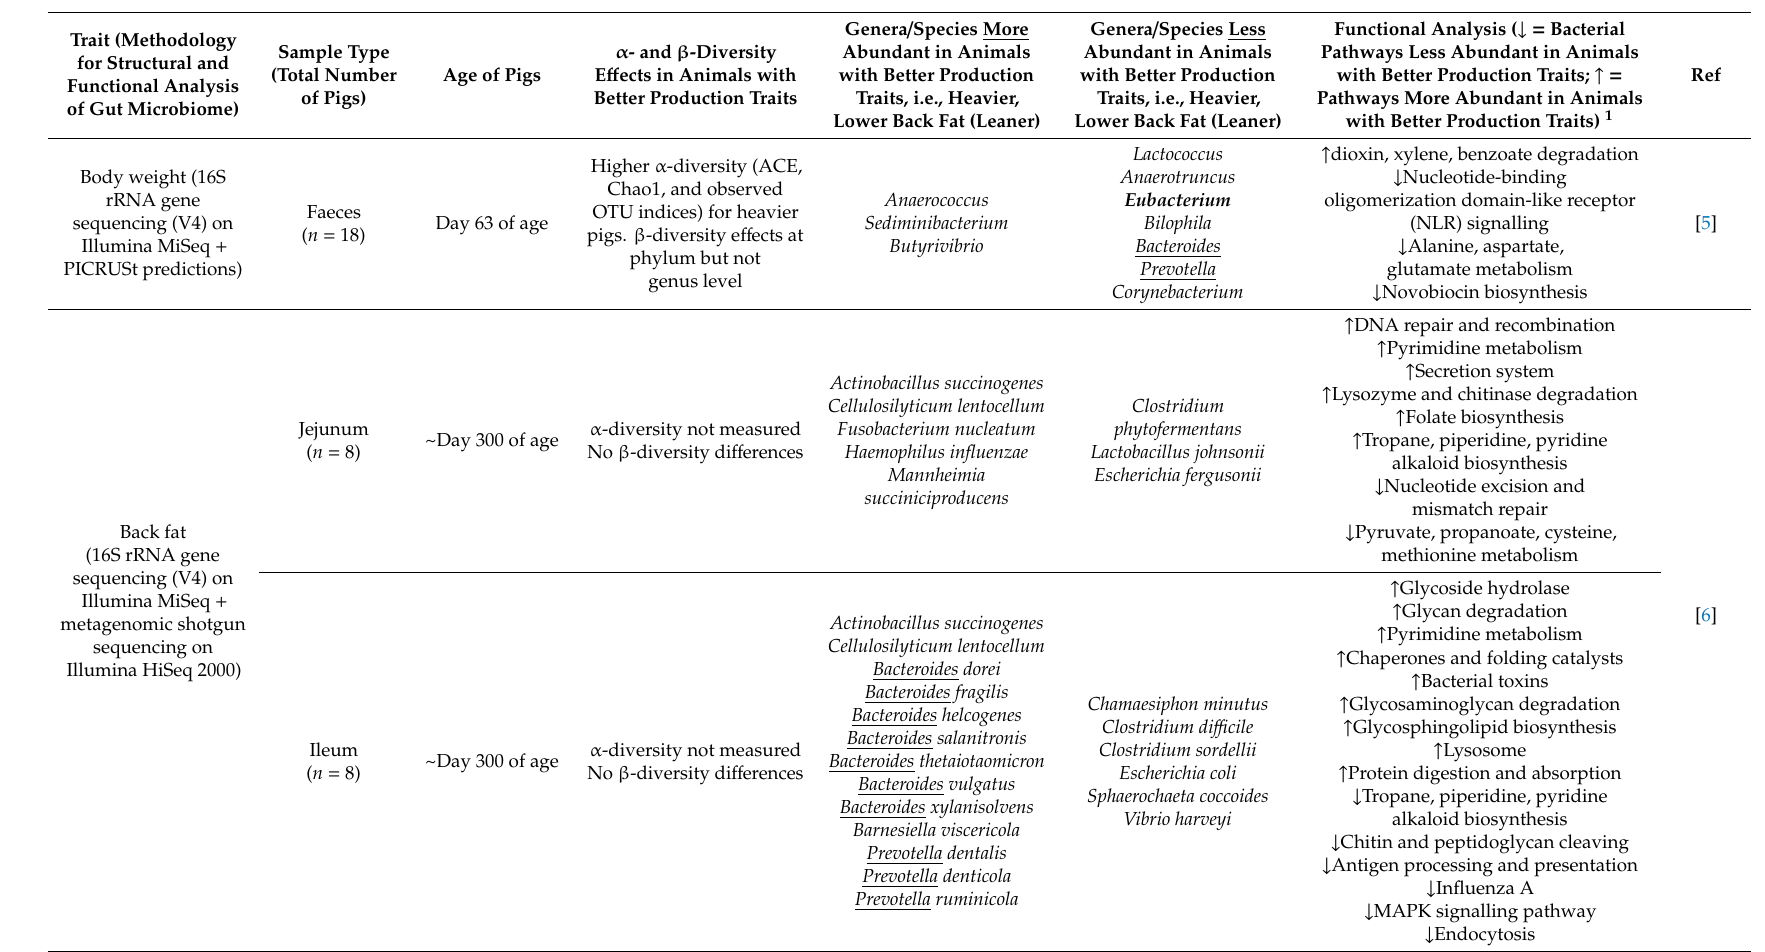
Table 1. Bacterial diversity within the gut microbiome of pigs ranked on growth / body composition traits and bacterial genera / species and related pathways / genes 1 linked with growth and body